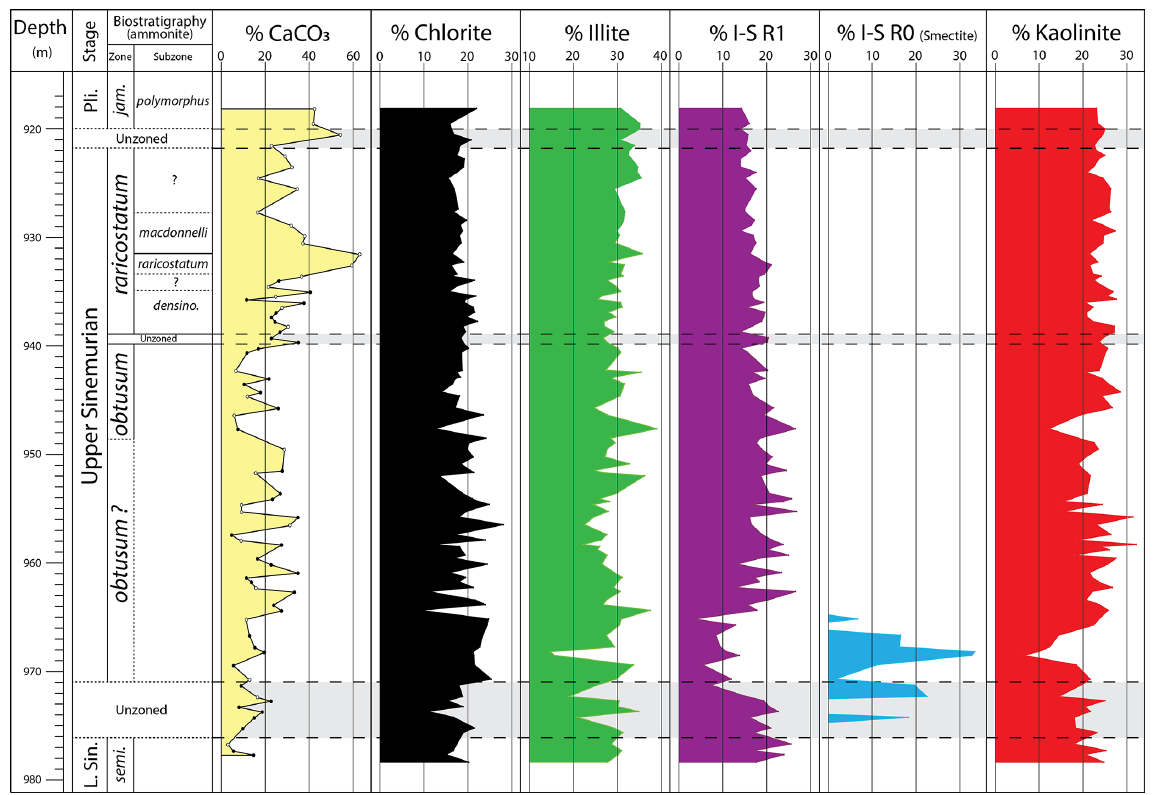
Figure 6. Calcite proportions and composition of the clay fraction of the upper Sinemurian strata of the Montcornet borehole. Abbreviations: densinod. – densinodulum , macdonn. – macdonnelli , Pli. – Pliensbachian, polymor. – polymorphus , raricost. – raricostatum